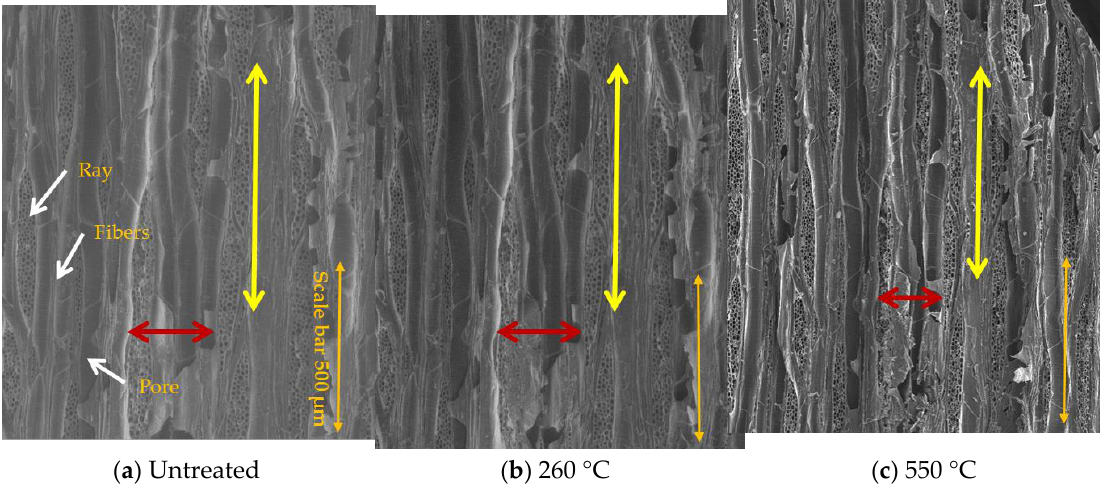
Figure 6. SEM images (horizontal field width = 1.28 mm; scale bar of 500 µm; vertical as images are presented) of the tangential section views of the untreated and the 260 and 550 °C treated cherry wood samples. White arrows indicate rays and fibers seen in end-view formed by stacks of ray parenchyma cells, also pores are visible in the tangential section images. Yellow bars indicate shrinkage along the axial direction using reference structures. Red bars mark shrinkage along the tangential direction using reference structures.